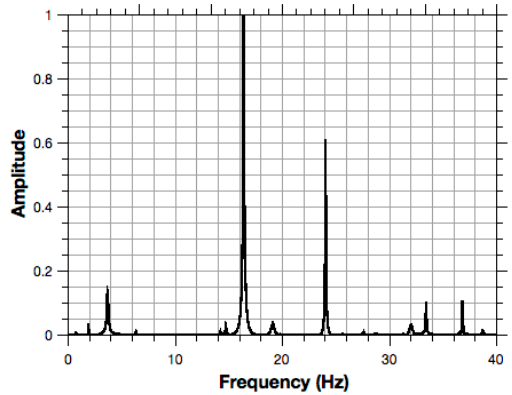
Figure 9. The oscillations outside the initial cylinder.